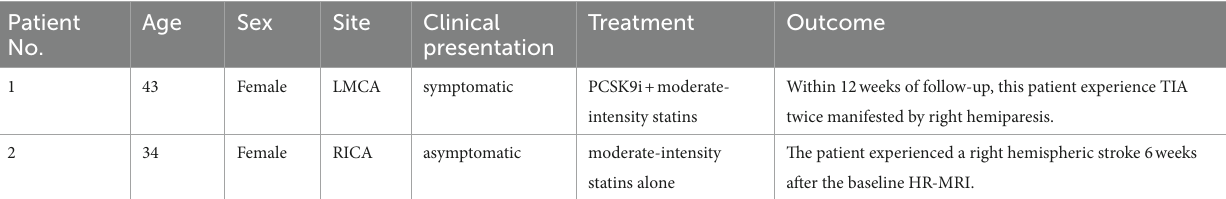
TABLE 4 Major vascular events during